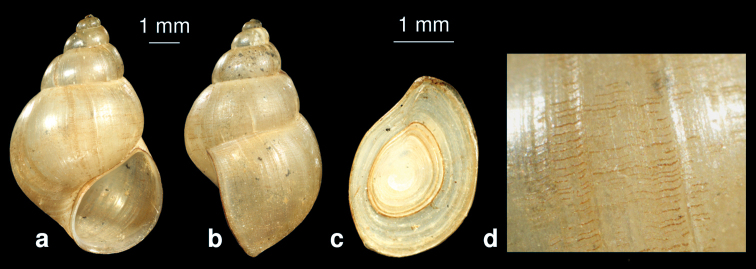
Bithynia mazandaranensissp. n. a, b shell c operculum d detail of the shell surface.